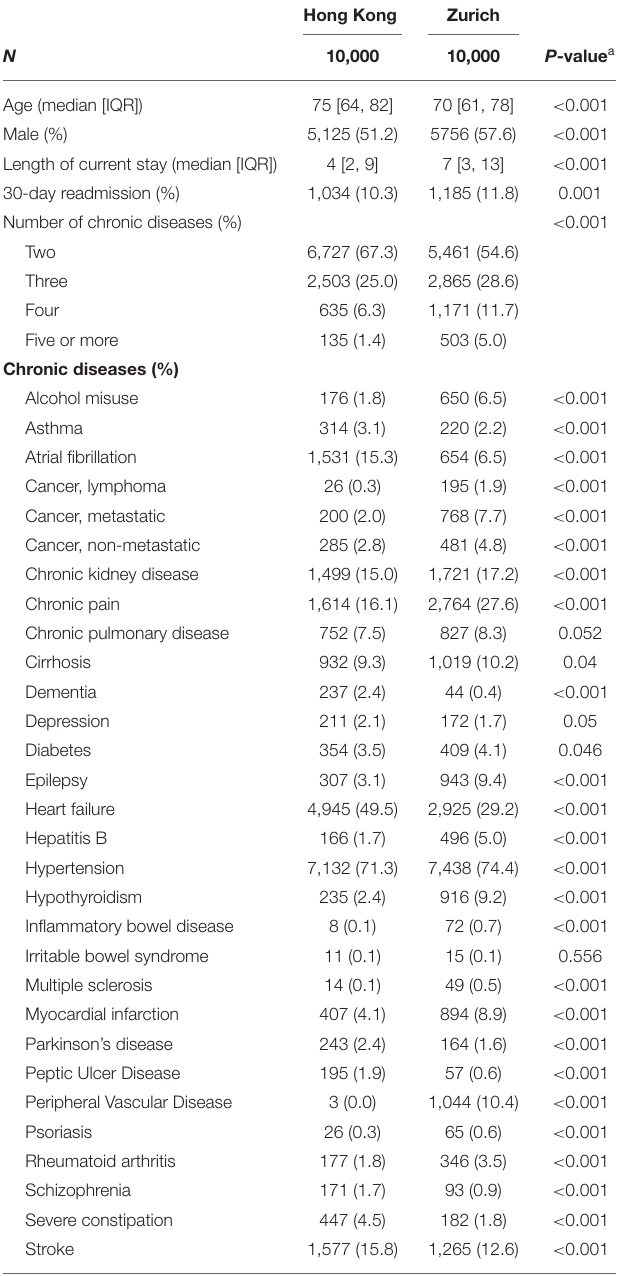
TABLE 1 | Comparison of demographics and disease prevalence between sites. Hong Kong